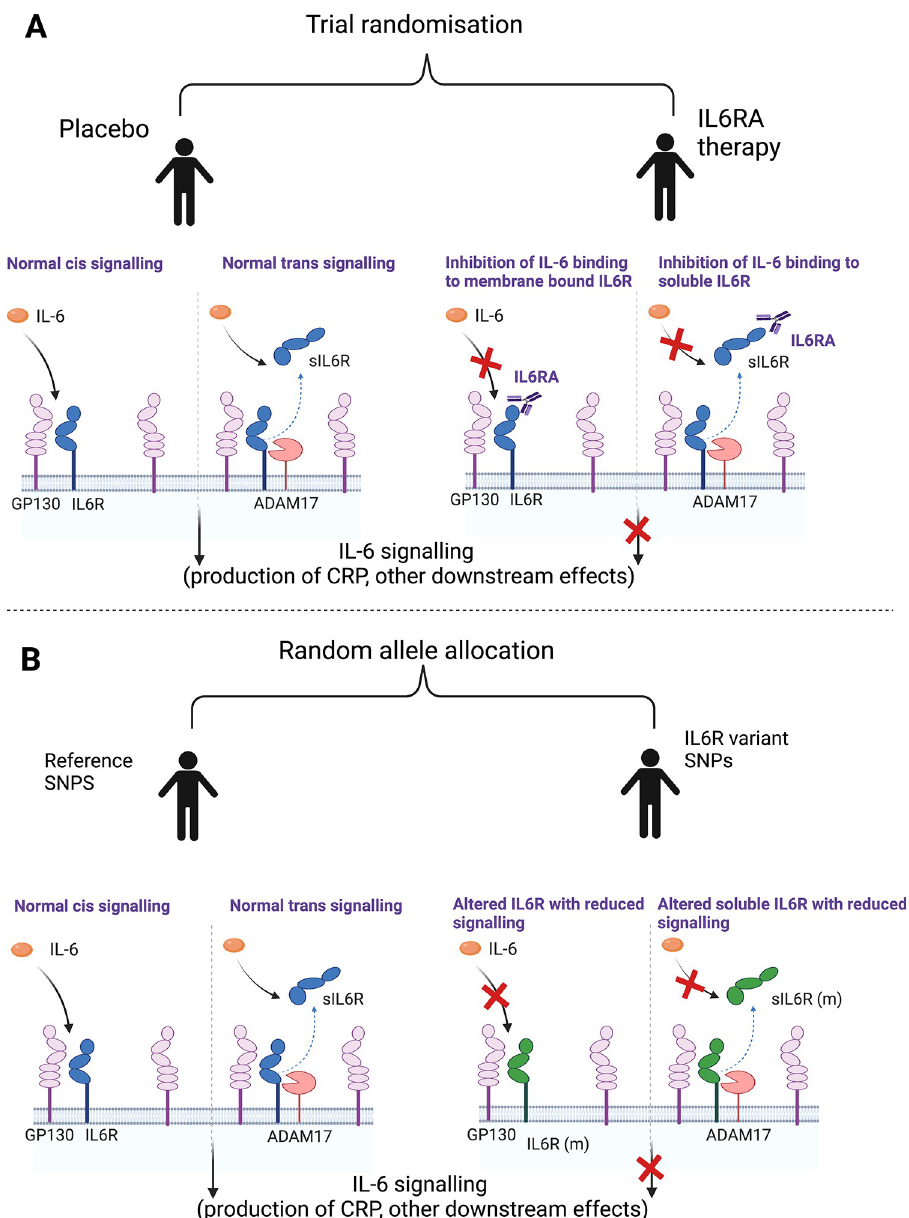
Fig 1. Section A represents a randomised trial of IL6RA therapy with both normal IL-6 signalling and the effect of intervention. Section B represents the use of SNPs in IL6R to act as a proxy for intervention. We identify variants within IL6R associated with reduced CRP as a marker of functional IL6R blockade to aid the interpretation of MR analysis. As these SNPs are within IL6R, we make the assumption that these SNPs have an effect through alteration of IL6R (either through modification of the protein itself or altering quantity of the protein). Image made using Biorender.com. ADAM17, A disintegrin and metalloprotease 17; CRP, C-reactive protein; GP130, Glycoprotein 130; IL-6, interleukin 6; IL6R, interleukin 6 receptor, IL6RA, interleukin 6 receptor antagonist; IL6R (m), modified interlekin 6 receptor; MR, Mendelian randomisation; sIL6R, soluble interleukin 6 receptor; SNP, single nucleotide